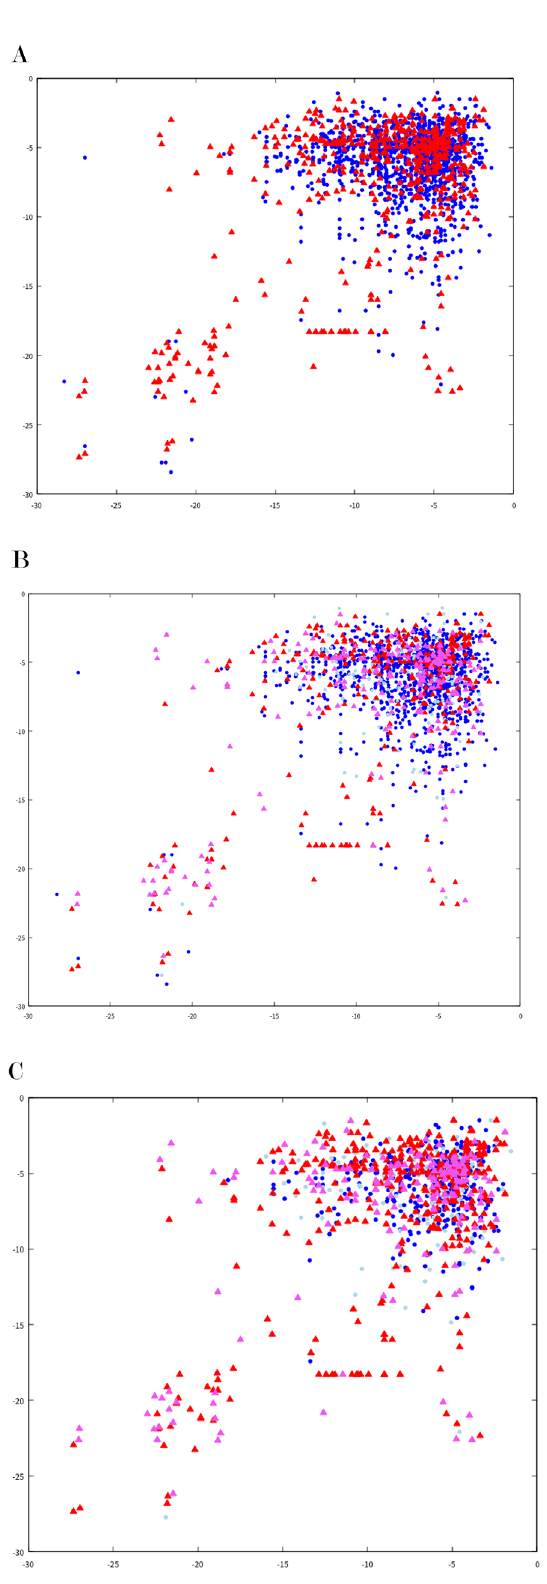
Figure 5. Scatter plot of PCR-results and predictions. Plot the PCR results and RNN-predictions against the Gibbs energy at the hydrogen bond at the forward (horizontal axis) and reverse (vertical axis) priming positions determined at the time of pseudo-sentence determination (Fig. 2). Colors and shape show the following results and predictions; red triangle: PCR-positive-prediction-positive, pink triangle: PCR-positive-prediction-negative, blue circle: PCR-negative-prediction-negative, light blue circle: PCR-negative-prediction-positive. Primer pair- template sets excluded from predictions during undersampling were not